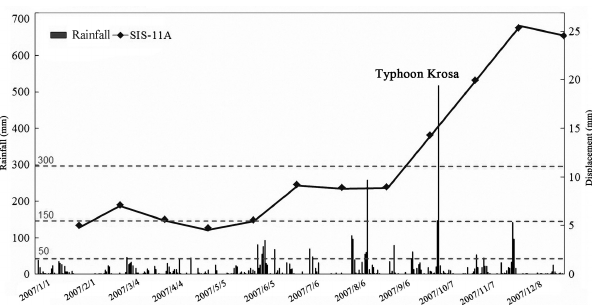
Figure 15. Slope stability (J-J’ cross section) for normal condition (FS min = 2.17).